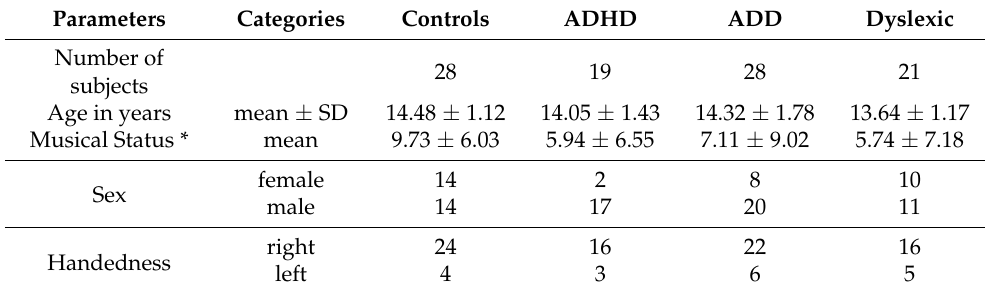
Table 1. Description of